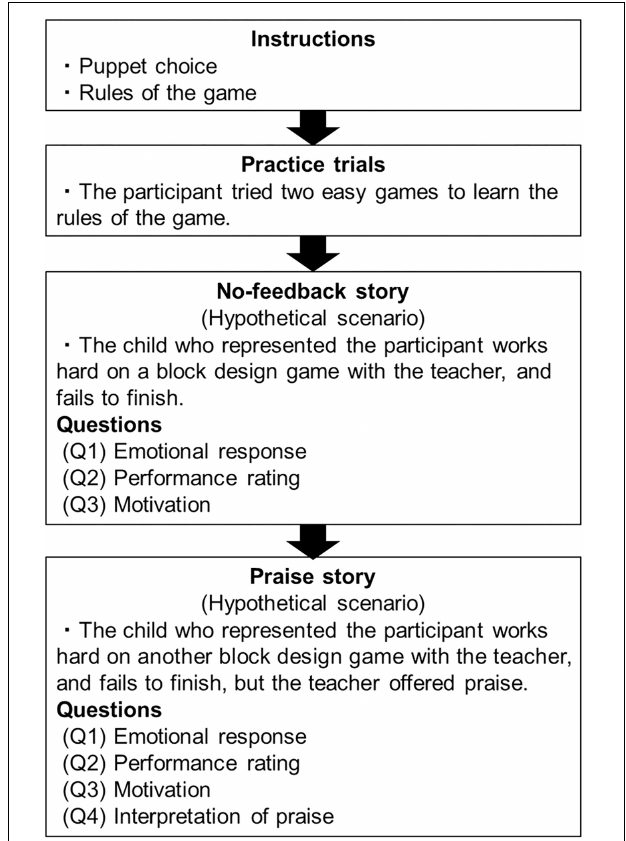
FIGURE 1 | Flow of the procedure for the failure-praise